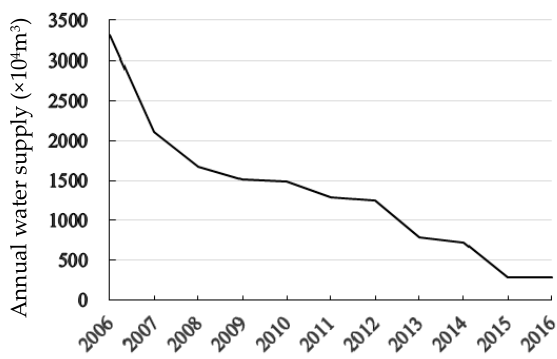
Figure 4. Groundwater availability of the Changning irrigation district (CN) from 2006 to 2016.